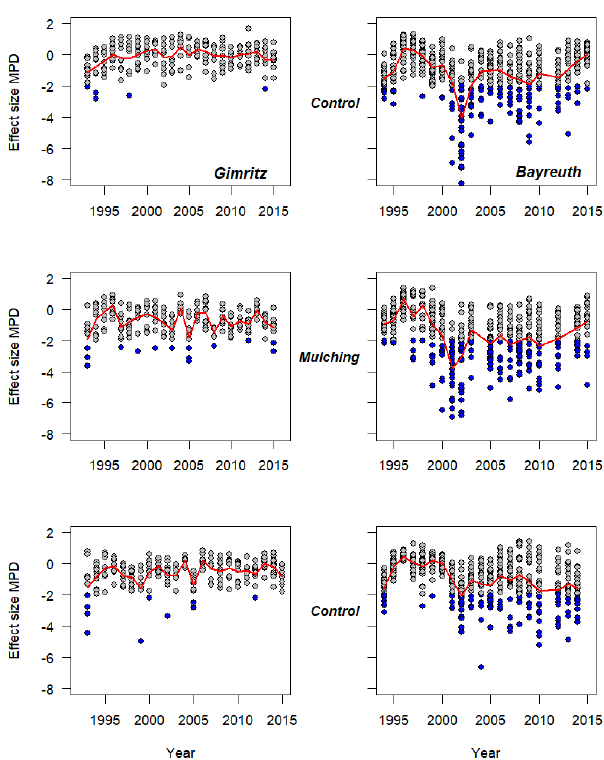
Figure 4. Trajectory of the effect sizes of the mean pairwise phylo- genetic distances (MPD) of plant communities within subplots for each treatment in Gimritz and Bayreuth. For details about calcu- lating the effect sizes see Material and Methods. Symbols in blue indicate significant mean effect sizes. The red line gives the mean effect sizes of the